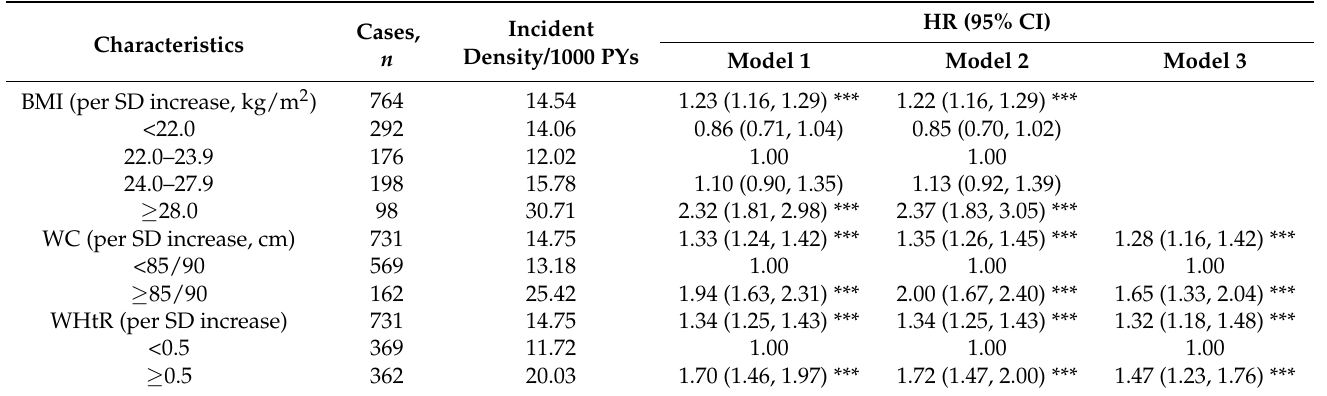
Table 2. The incident risk of T2DM associated with baseline BMI, WC, and the WHtR.